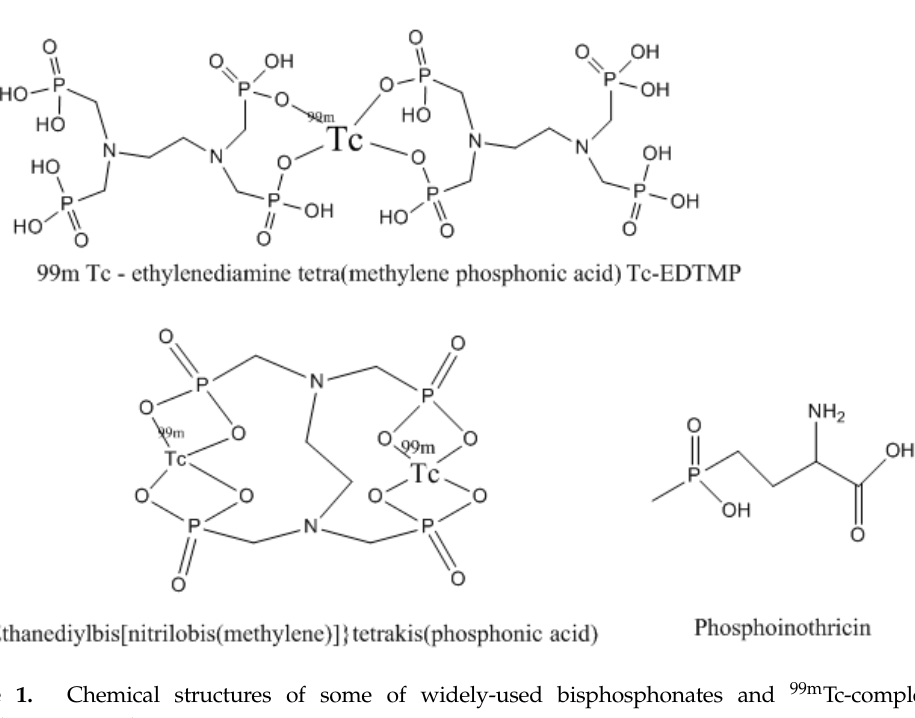
Figure 1. Chemical structures of some of widely-used bisphosphonates and 99m Tc-complex radiopharmaceuticals.